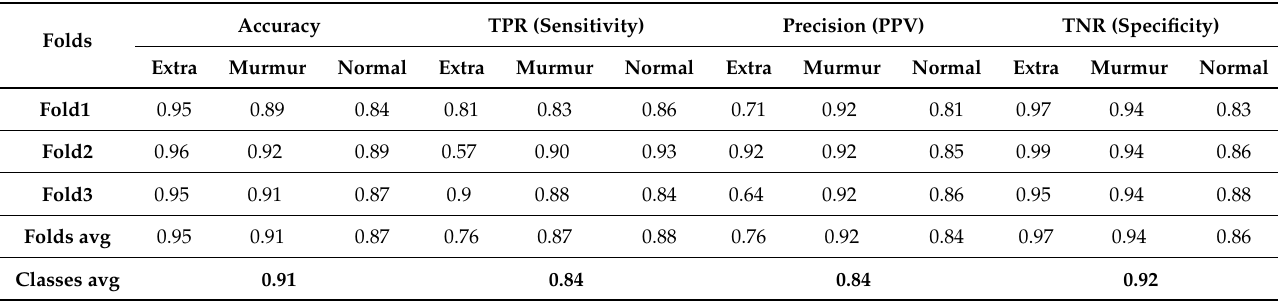
Table 9. Detailed average results of our model (VGG19) in terms of micro accuracy, micro TPR, micro precision, and micro specificity.